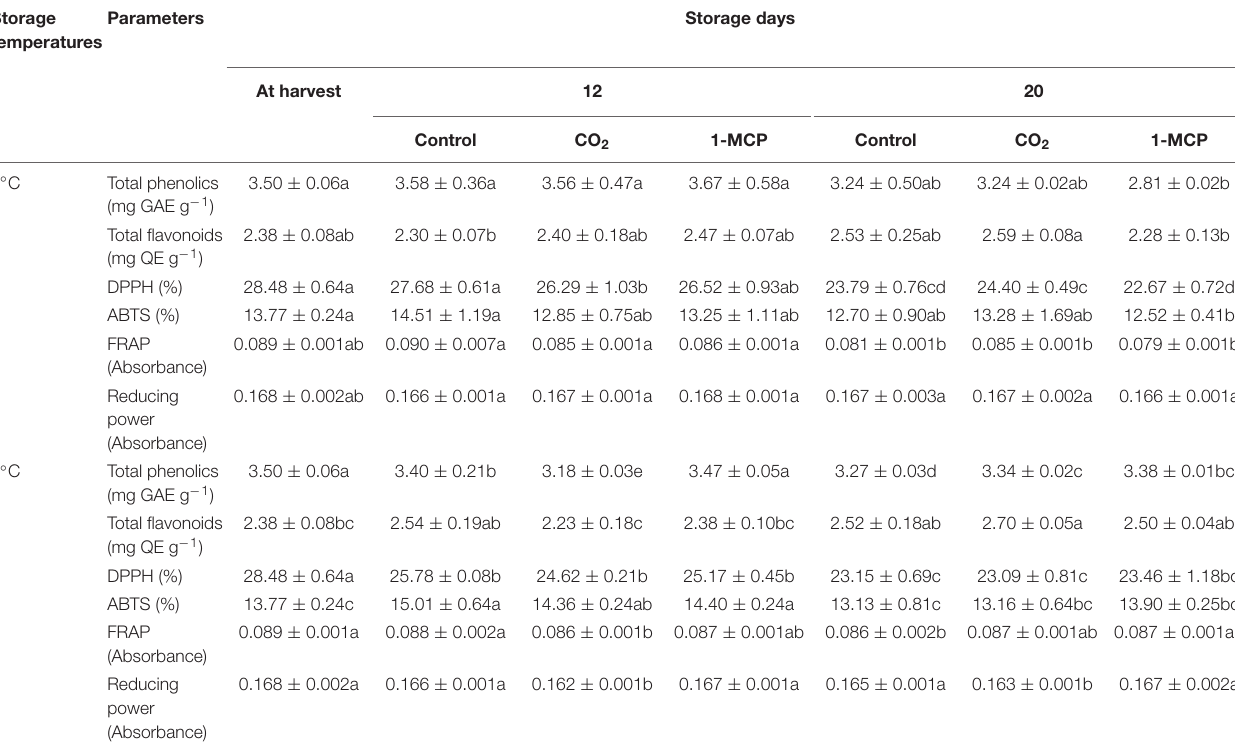
Storage Parameters Storage temperatures